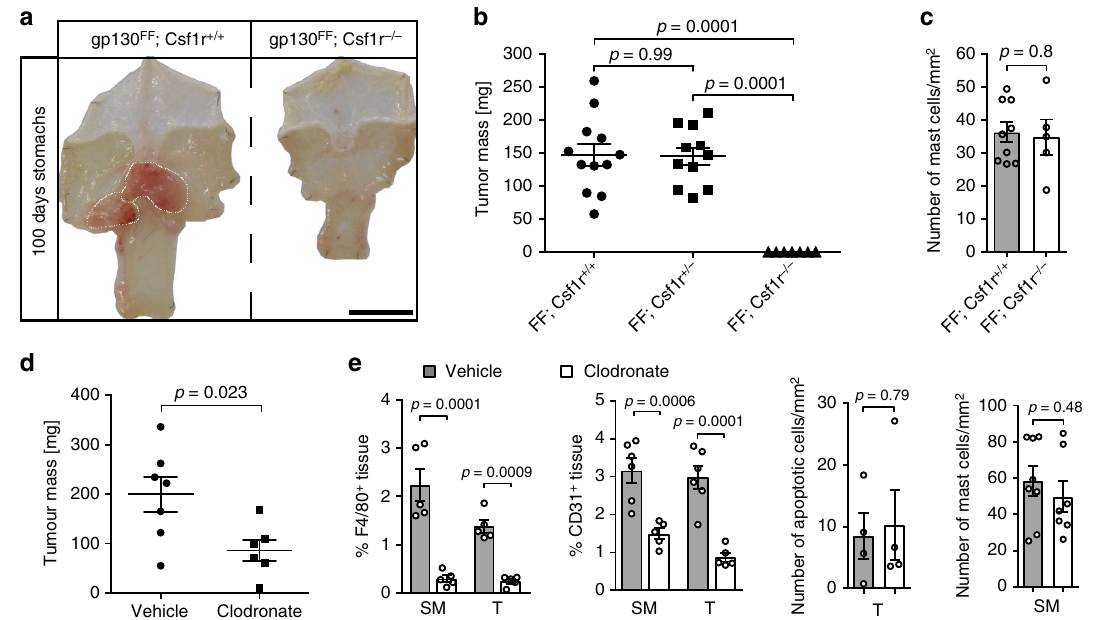
Fig. 4 Tumor burden in gp130 FF mice diminishes upon macrophage depletion. a Representative whole mount of stomachs from 100-day-old mice of the indicated genotype. Scale bar = 1 mm. b Quanti fi cation of total tumor burden per mouse as in ( a ). Each symbol represents an individual mouse. Due to ill health some gp130 F/F ; Csf1r − / − mice had to be analyzed before the 100 day endpoint; average mouse age per groups were: gp130 F/F ; Csf1r + / + 88.2 days, gp130 F/F ; Csf1r + / − 90.4 days, and gp130 F/F ; Csf1r − / − 81.6 days. One-way ANOVA F (DFn, Dfd) = 27.55 (2, 27). c Quanti fi cation of mast cell density in antral submucosa of indicated genotype was performed with gp130 F/F ; Csf1r + / + n = 9 and gp130 F/F ; Csf1r − / − n = 5 biological samples from